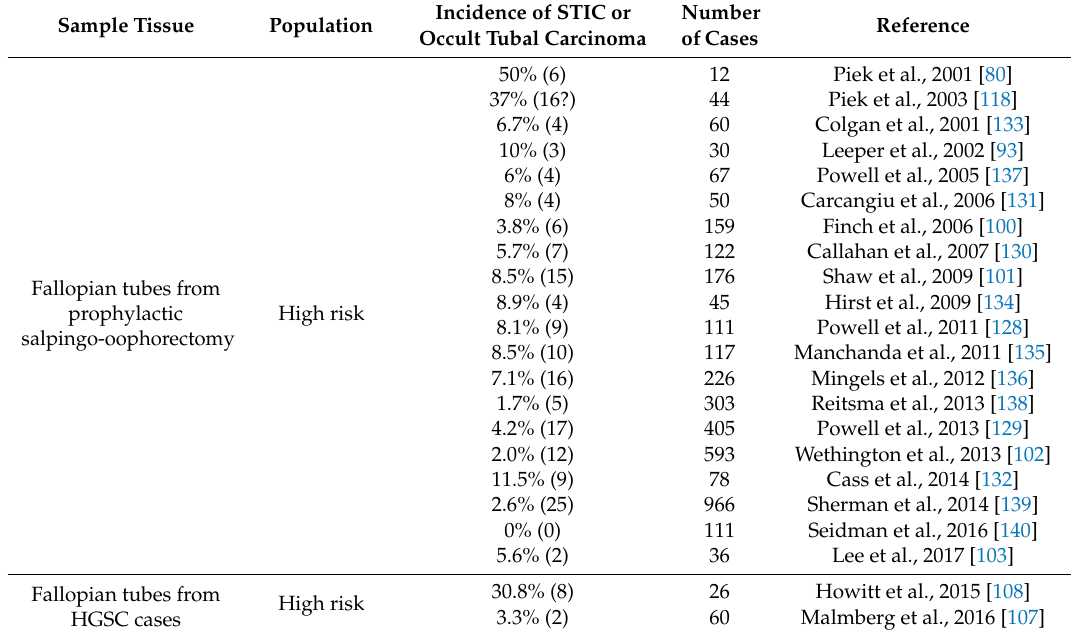
Table 3. Incidence of STIC in high-risk women and in the general